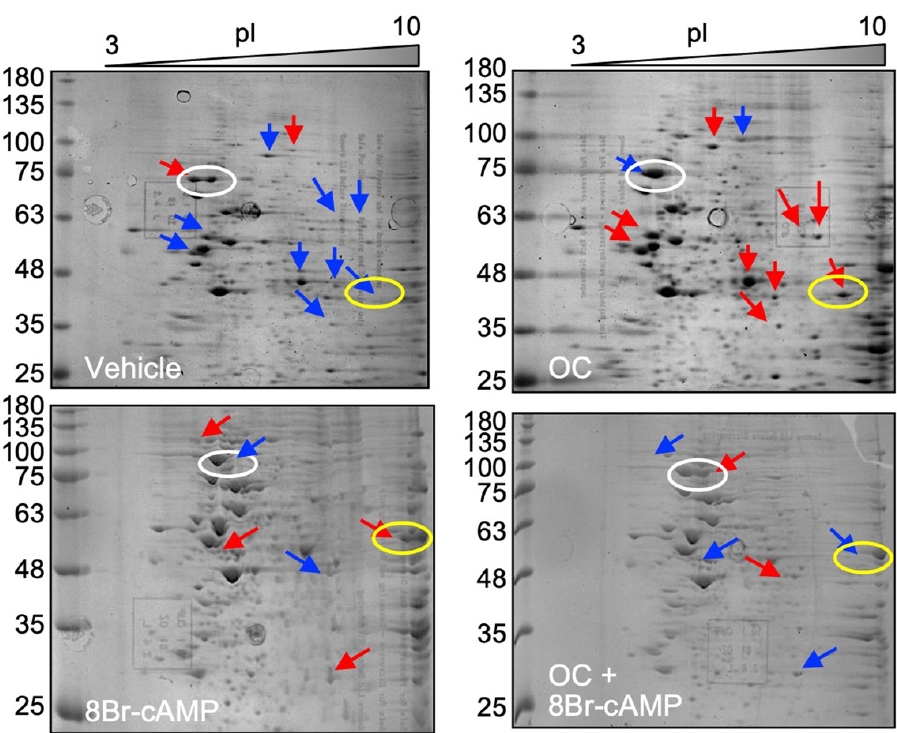
Figure 3. Exposure to the OC mixture affects several proteins in Leydig cells. MA-10 Leydig cells were treated with either DMSO or 10 µg/mL of the OC mixture for 2 h and then treated for another 4 h with or without 0.1 mM 8Br-cAMP as indicated. The Coomassie blue-stained two-dimensional SDS-PAGE gels were scanned, and spots were matched and quantified using ImageMaster 2D Plat- inum 6.0 software. Red and blue arrows represent increased and decreased protein spots, respec- tively. Circled spots (white = Sample 1; yellow = Sample 2) were analyzed by LC-MS/MS for protein